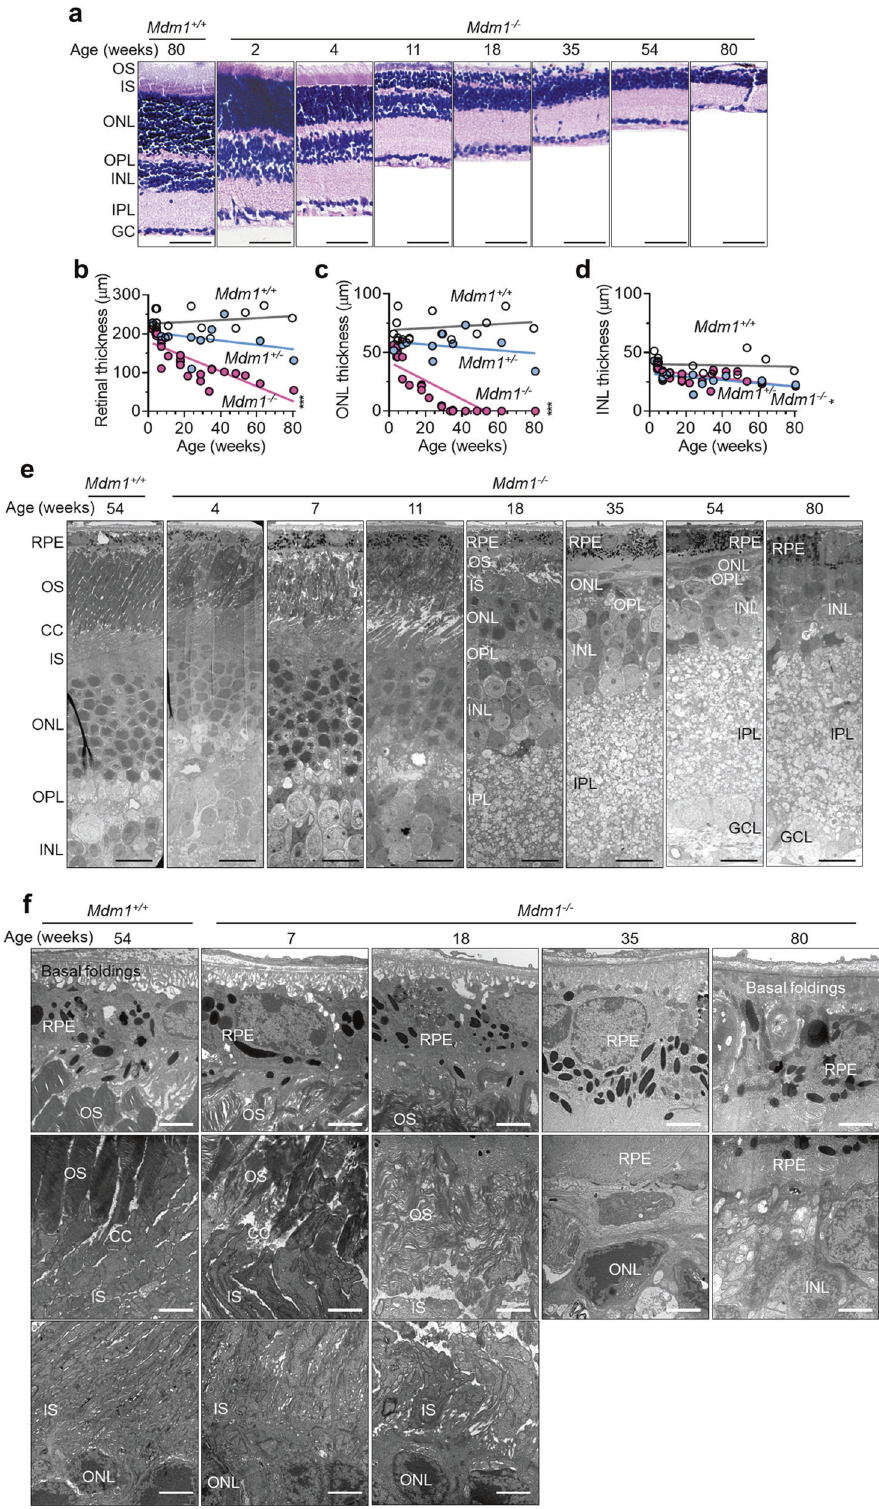
Fig. 4 Histological and TEM analyses of retinal structures in Mdm1 + / + and Mdm1 − / − mice. a Representative images of hematoxylin and eosin (H&E) stained retinal sections of Mdm1 + / + or Mdm1 − / − mice at the indicated ages. Scale bar, 50 μ m. Quanti fi cation of retinal thickness of Mdm1 + / + and Mdm1 − / − mice with increasing age ( b – d ) ( n = 15, 10, and 27 mice in Mdm1 + / + , Mdm1 + / − , and Mdm1 − / − mice, respectively). b Total retinal thickness. c ONL thickness. d INL thickness. e TEM images of the retinas in female Mdm1 + / + or Mdm1 − / − mice of the indicated ages. Scale bar, 10 μ m. f Ultrastructural analysis of the retinas in Mdm1 + / + or Mdm1 − / − mice at the indicated ages. Scale bar, 2 μ m. GC, ganglion cell; IPL, inner plexiform layer; INL, inner nuclear layer; OPL, outer plexiform layer; ONL, outer nuclear layer; IS, inner segment; OS, outer segment; RPE, retinal pigment epithelium; CC, connecting cilium. Statistical analysis, linear regression.